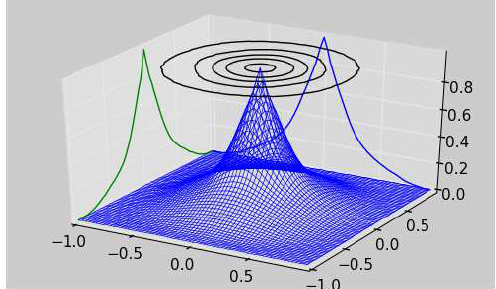
Figure 7 : 2D MTF for the PA band, up to 2 f Nyquist